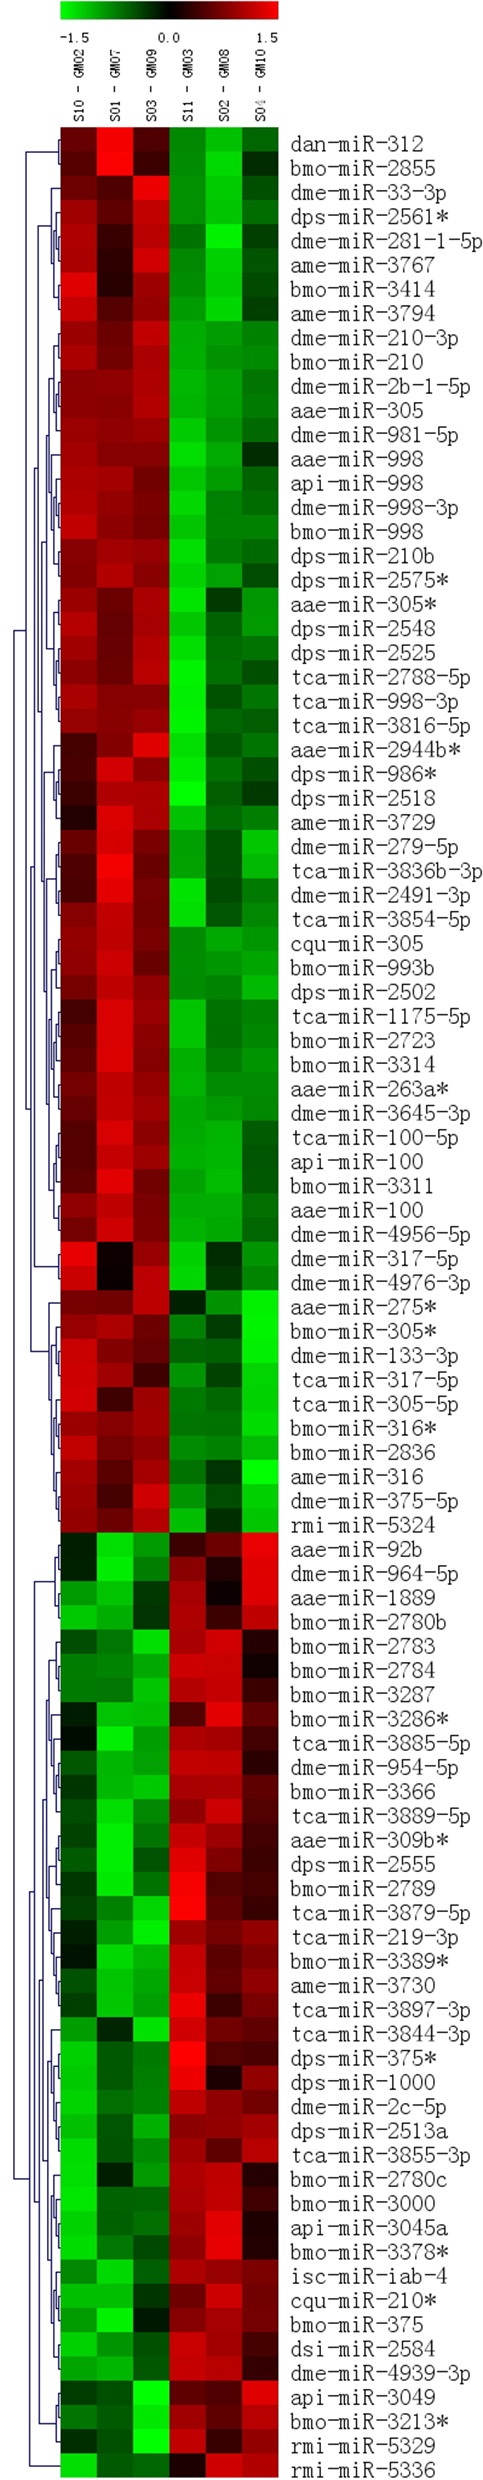
Heat map of miRNA microarray was generated between control and infected G. mellonella. This figure shows a set of statistically significant deregulated miRNAs upon infection with L. monocytogenes (p ≤ 0.01). Red, increased expression; Green, reduced expression. The lines in heat map: GM02, GM07, and GM09 represent control samples; GM03, GM08, and GM10 represent infected samples.